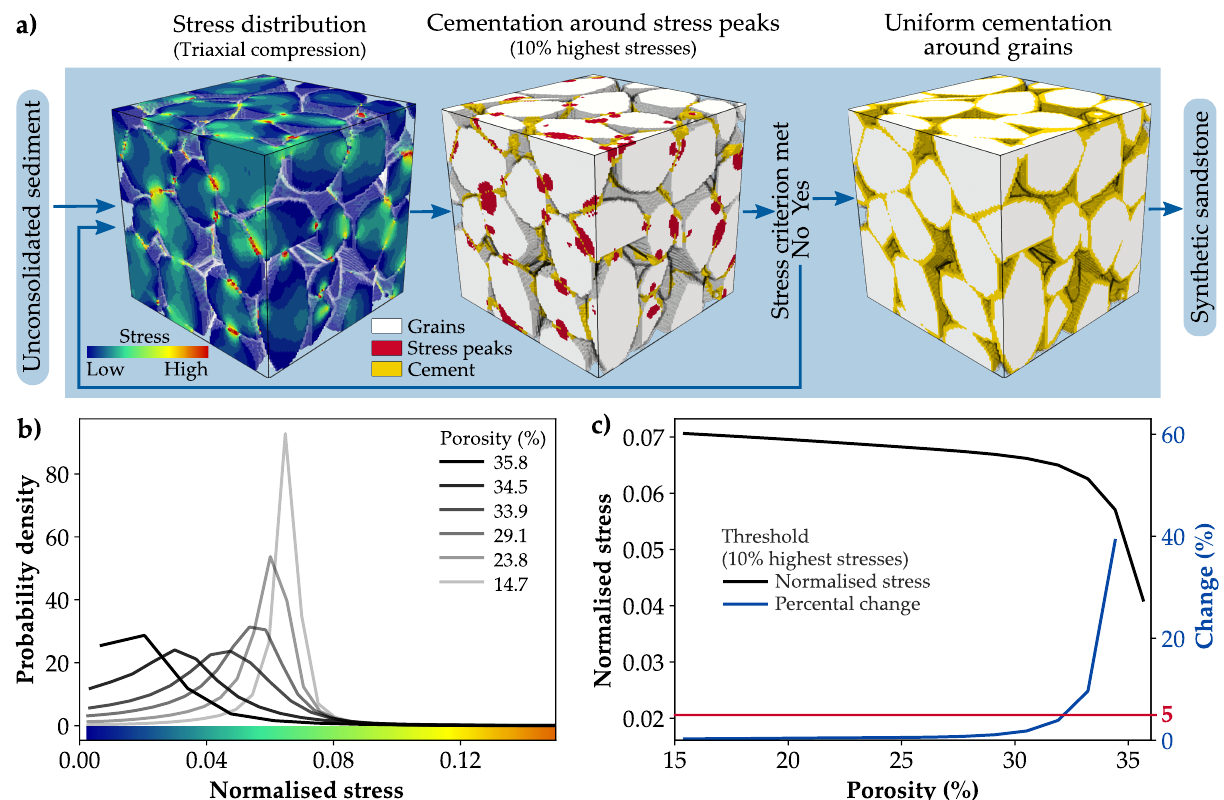
Figure 4. Schematic workflow of the stress-dependent cementation process: ( a ) Stress peaks (red) are determined by triaxial compression and the grain-lining voxels in their vicinity (yellow) are iteratively cemented until the stress criterion is met. Afterwards, the sample is uniformly cemented until the pre-defined porosity is achieved. ( b ) Evolution of the normalised stress distribution and ( c ) changes of the stress peak-defining threshold with decreasing porosity for the synthetic Fontainebleau sample. The stress criterion is met, when the threshold changes by less than 5% (red